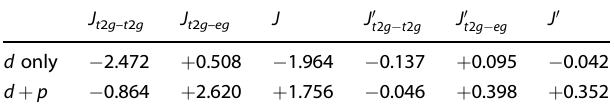
Fig. 2 d -only density of states. Purple and yellow denote Cr t 2 g and e g contributions, respectively. Coulomb matrix elements from Table 1 are used. Table 2. Orbital-resolved exchange interactions from MFT in meV.